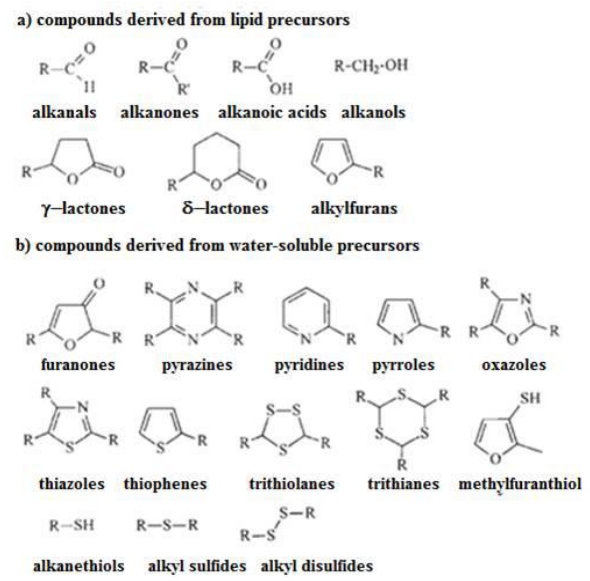
Figure 1. Major classes of volatile compounds produced during the cooking of chicken meat (Mottram,